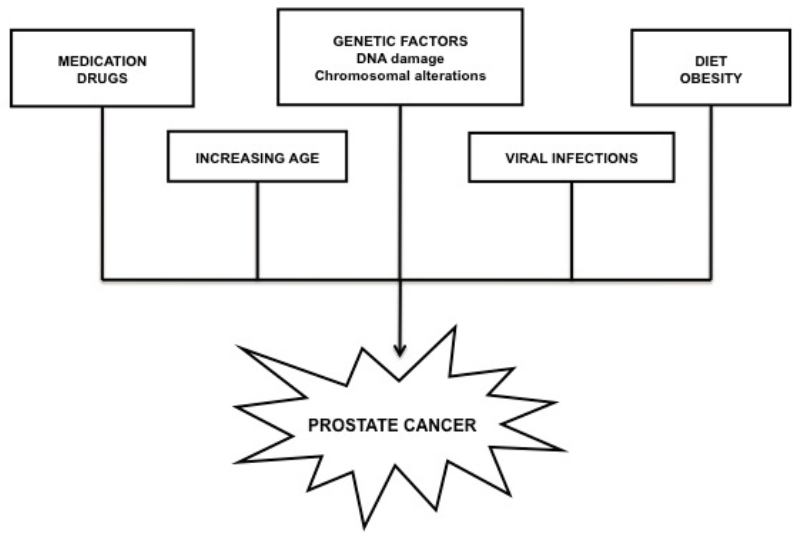
Figure 2. The most common causes contributing to prostate cancer